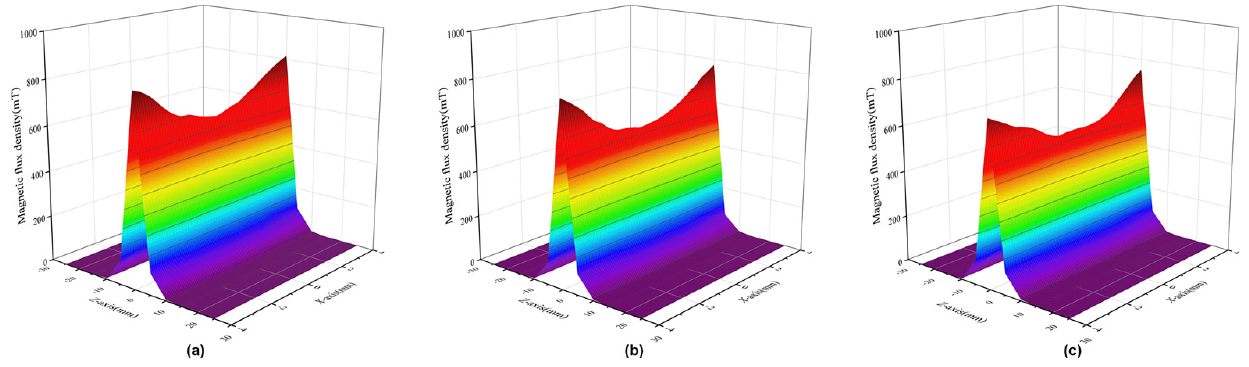
Figure 7. Influence of the chamfer on the magnetic field of the sensor: ( a ) 45° chamfer; ( b ) 60° cham- fer; ( c ) 75° chamfer.